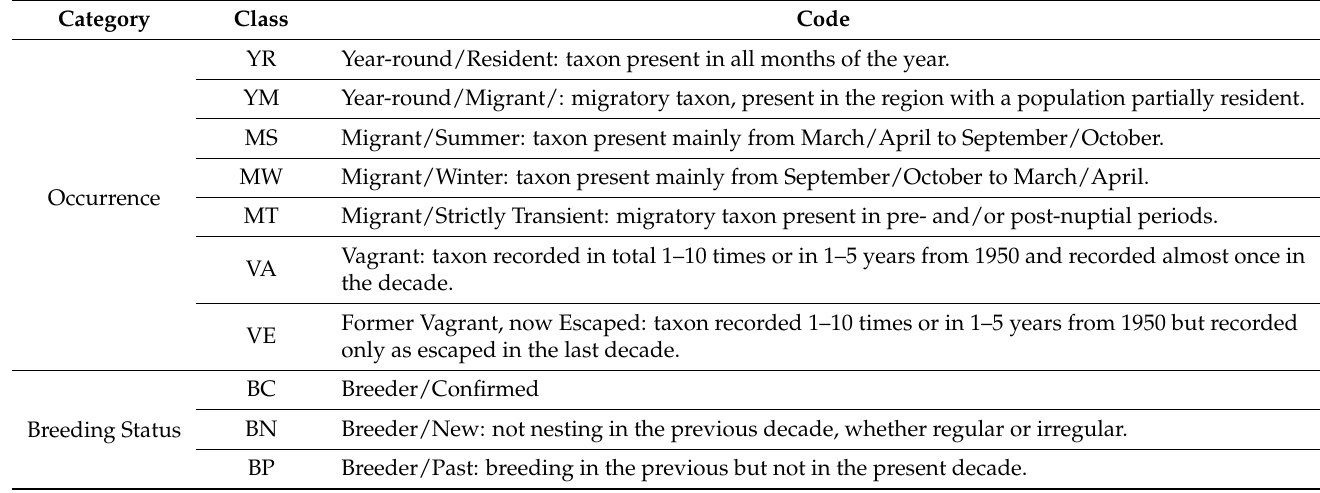
Table 2. Alphabetical codes defined for each taxon belonging to the OCL (2010–2019) (see text for details). In the Operational Checklist, the breeding status and occurrence codes are followed, where appropriate, by an “r” (taxon regularly present in at least nine of the ten years from 2010 to 2019) or an “i” (taxon irregularly present in less than nine of the ten years from 2010 to 2019). Code